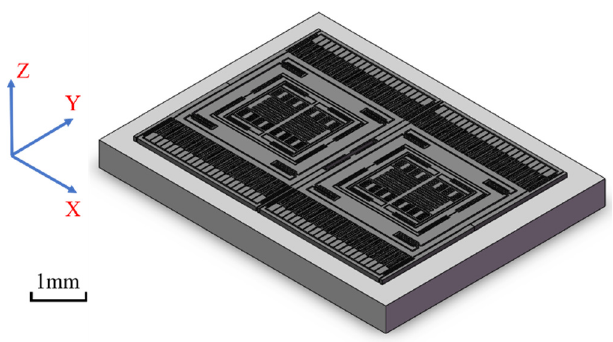
Figure 4. Schematic view of a MEMS tuning fork gyroscope.